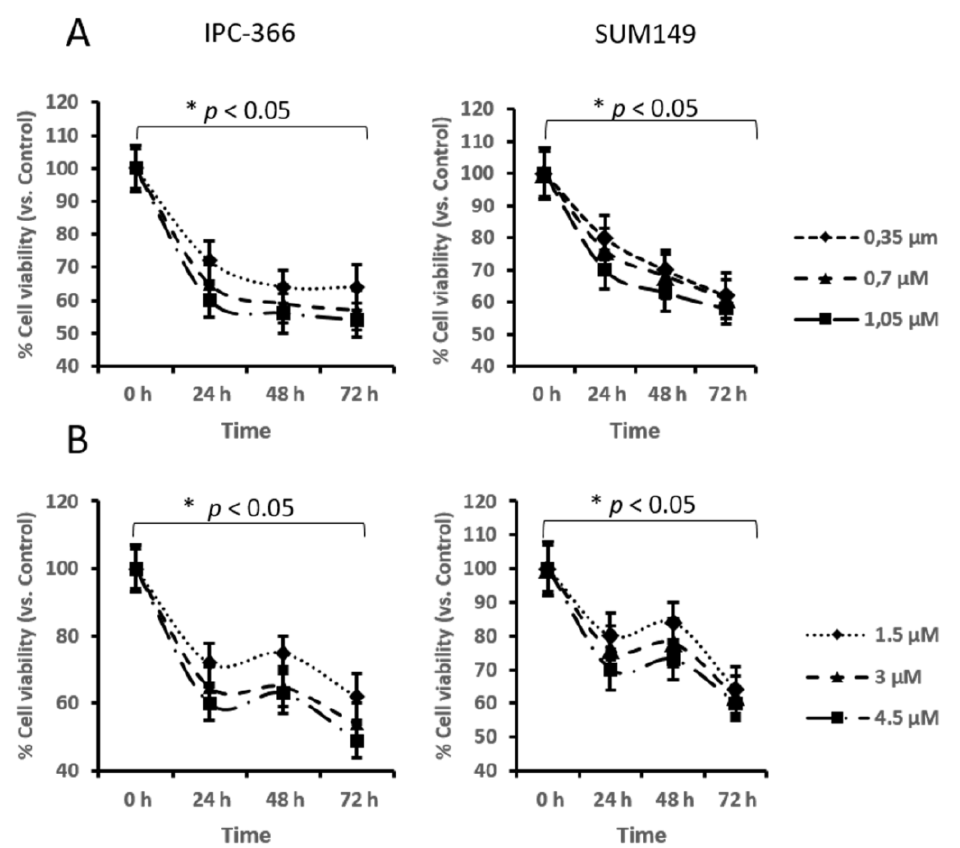
Figure 1. MTT assay results from letrozole ( A ) and STX ( B ) treatments from IPC-366 and SUM149 culture cells. * denoted significant differences ( p < 0.05) between control and treatments.